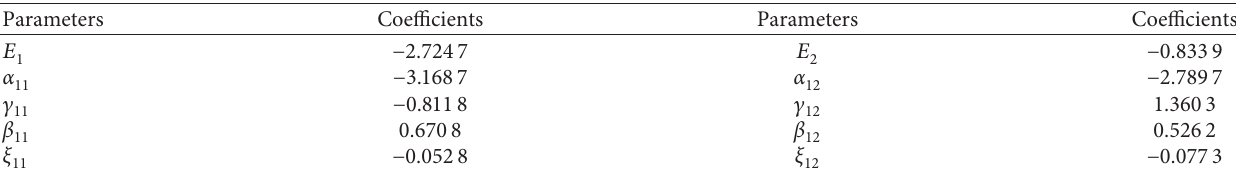
Figure 6: The realized volatility of daily S&P 500 series. Table 4: The estimated parameters of fuzzy-EGARCH-ANN model on the first 800 given S&P 500 data